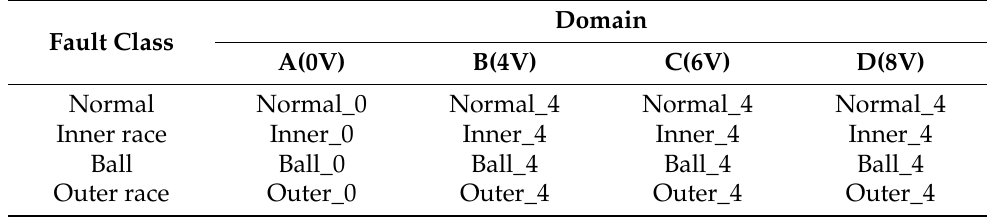
Table 1. Data description of the DDS dataset.